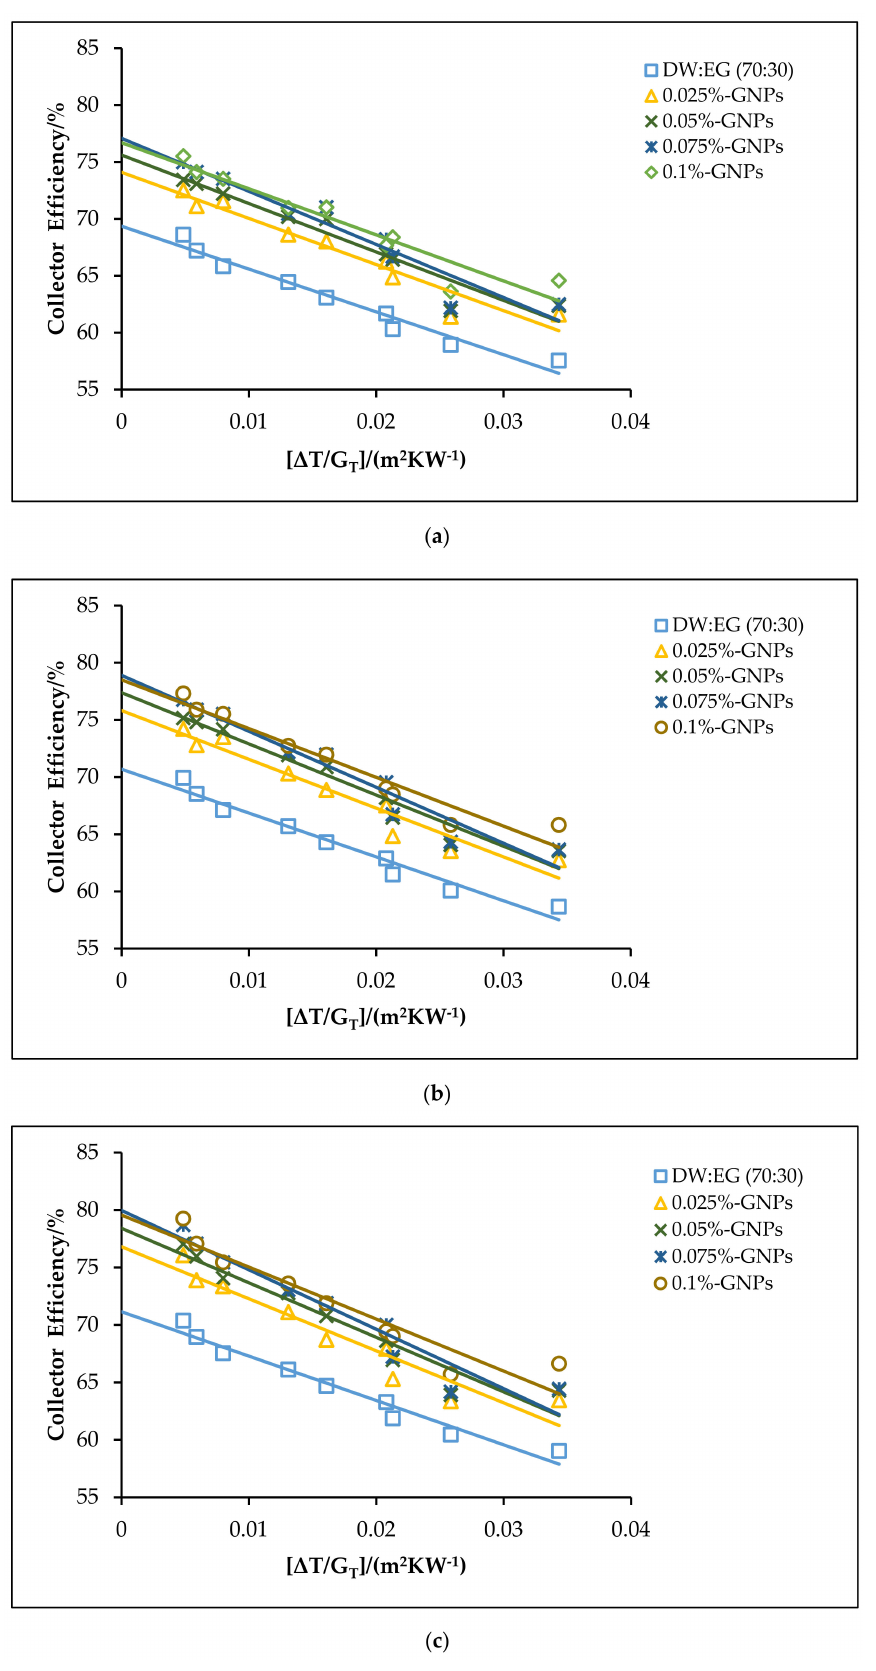
Figure 11. The theoretical efficiencies for the DW:EG (70:30)-based f-GNPs nanofluids with different weight concentrations: ( a ) 0.5 kg min − 1 ; ( b ) 1 kg min − 1 ; ( c ) 1.5 kg min − 1